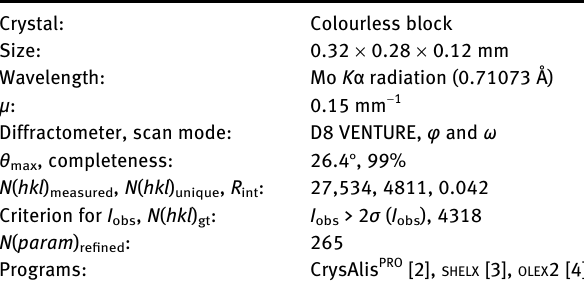
Table  : Data collection and handling.